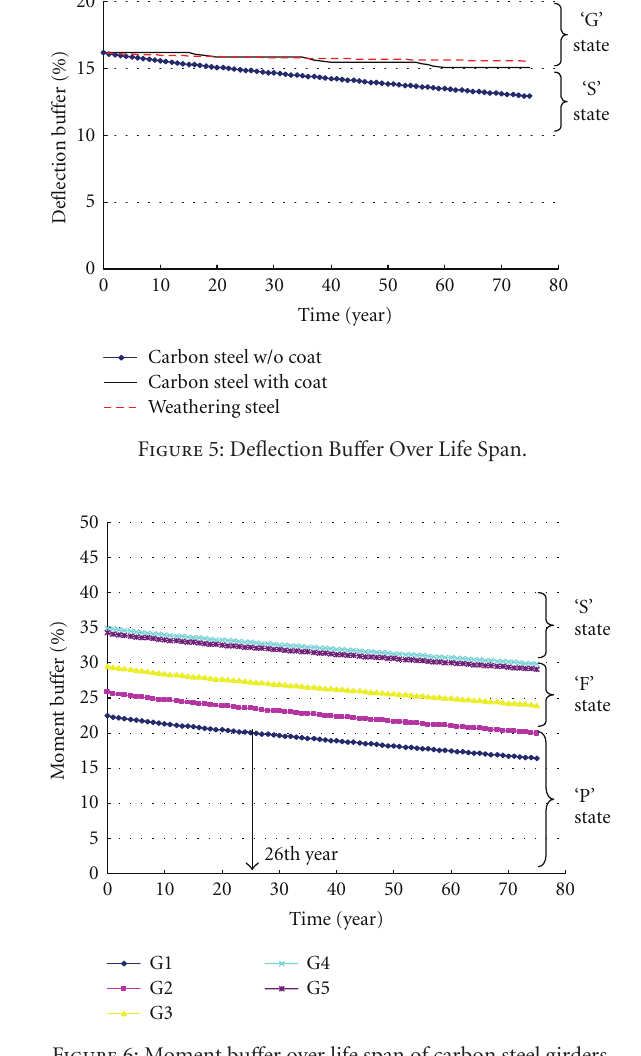
Figure 6: Moment bu ff er over life span of carbon steel